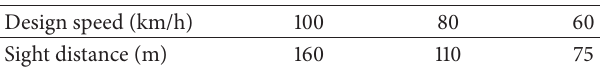
Table 7: Minimum sight distance standard according to design speed.